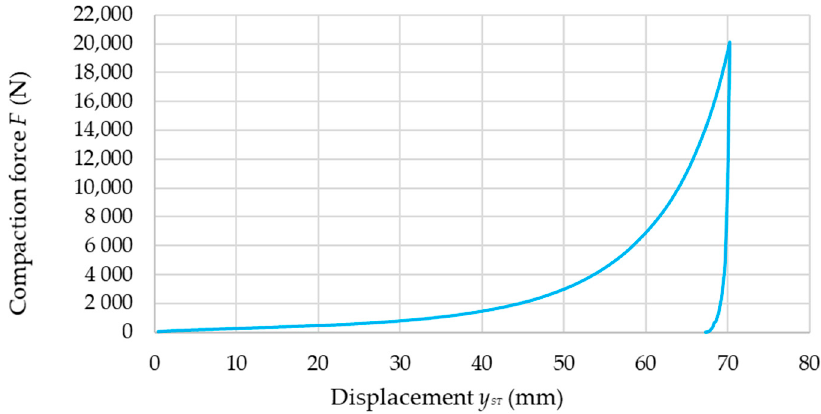
Figure 4. Characteristic curve of the variance of the compaction force in the process of compaction– unloading of oak sawdust when compressed with a force of F = 20,000 N.